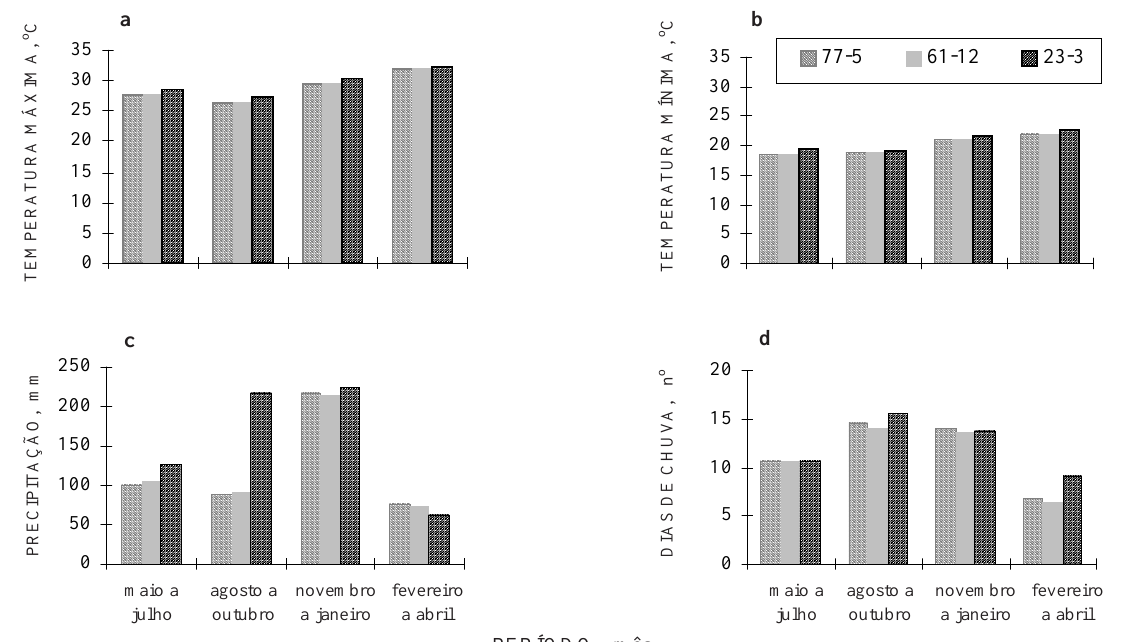
Figura 1. Médias das temperaturas máximas (a), das temperaturas mínimas (b), das precipitações (c) e dos números de dias de chuva (d) no período de maio de 1992 a abril de 1993 nas áreas 77-5 e 61-12, em Aracruz, e na área 23-3, em São Mateus. Os dados das áreas 77-5 e 61-12 são médias de duas estações climatológicas e os da área 23-3 são médias de